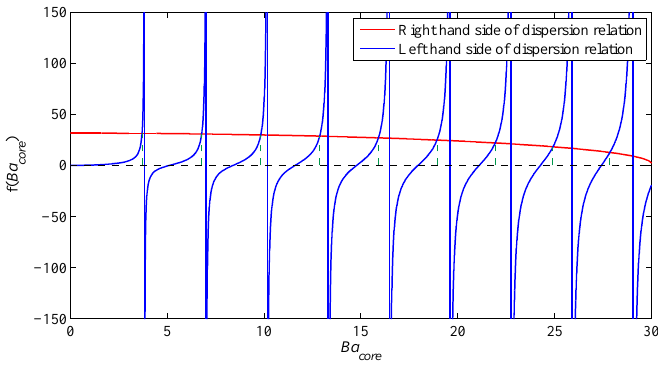
Figure 2. Analytical dispersion results for step index fibers (Table 1), l = 1.